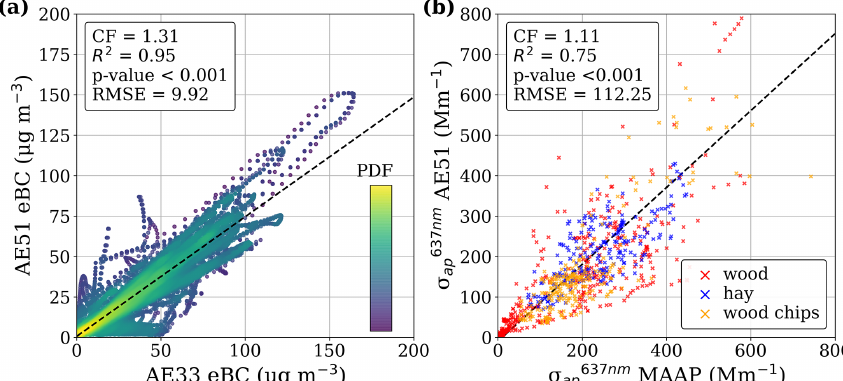
Figure 5. (a) Correlation between the AE51 aethalometer and the AE33 multi-wavelength aethalometer at λ = 880nm. Colours describe the point density formula (PDF) with lighter shades representing more common values. (b) Correlation between the absorption coefficient from the AE51 aethalometer (averaged over 10s) and the wavelength-corrected absorption coefficient from the MAAP. Both figures indicate a bias, represented by the calibration factor (CF) where the AE51 slightly underestimates the absorption compared with the